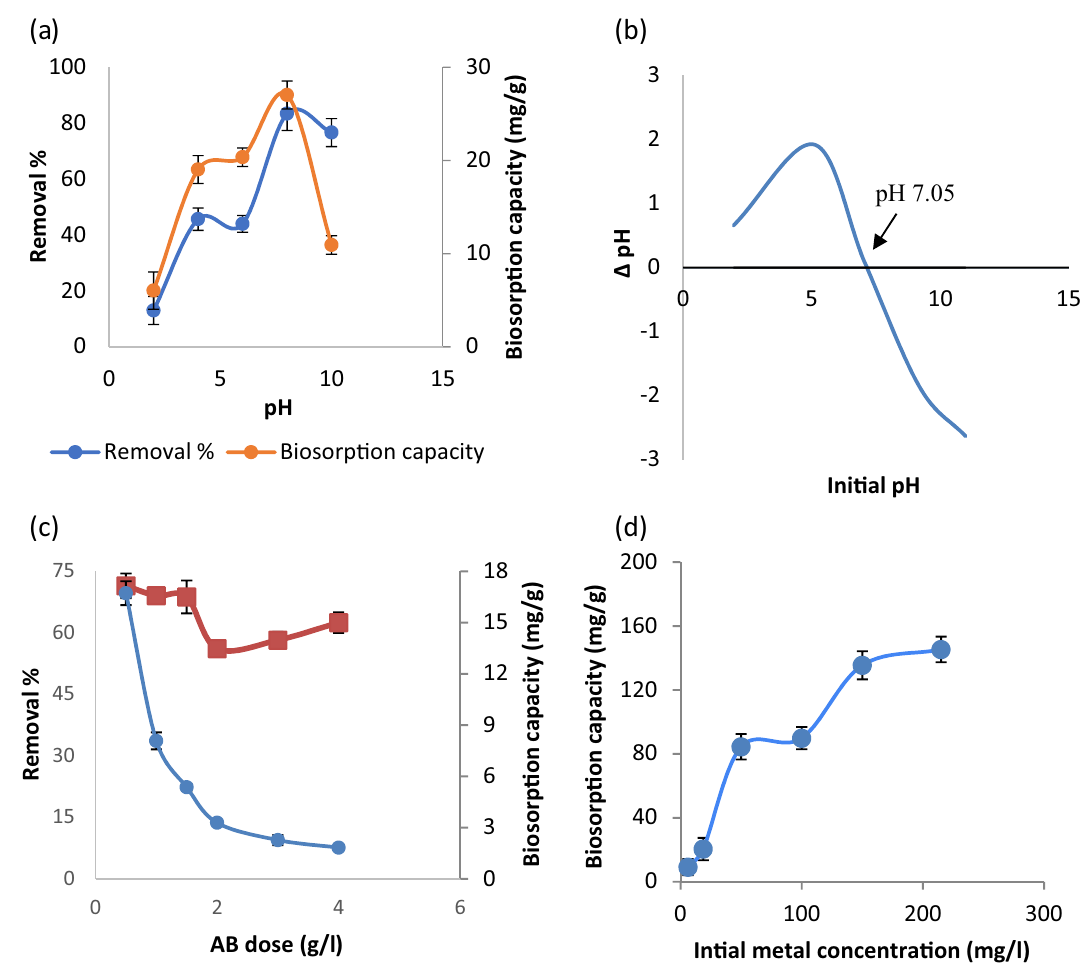
Figure 2. Biosorption properties of Cd ions using dry archaeal biomass (AB); ( a ) effect of pH, ( b ) isoelectric point of AB, ( c ) AB dose, ( d ) initial metal